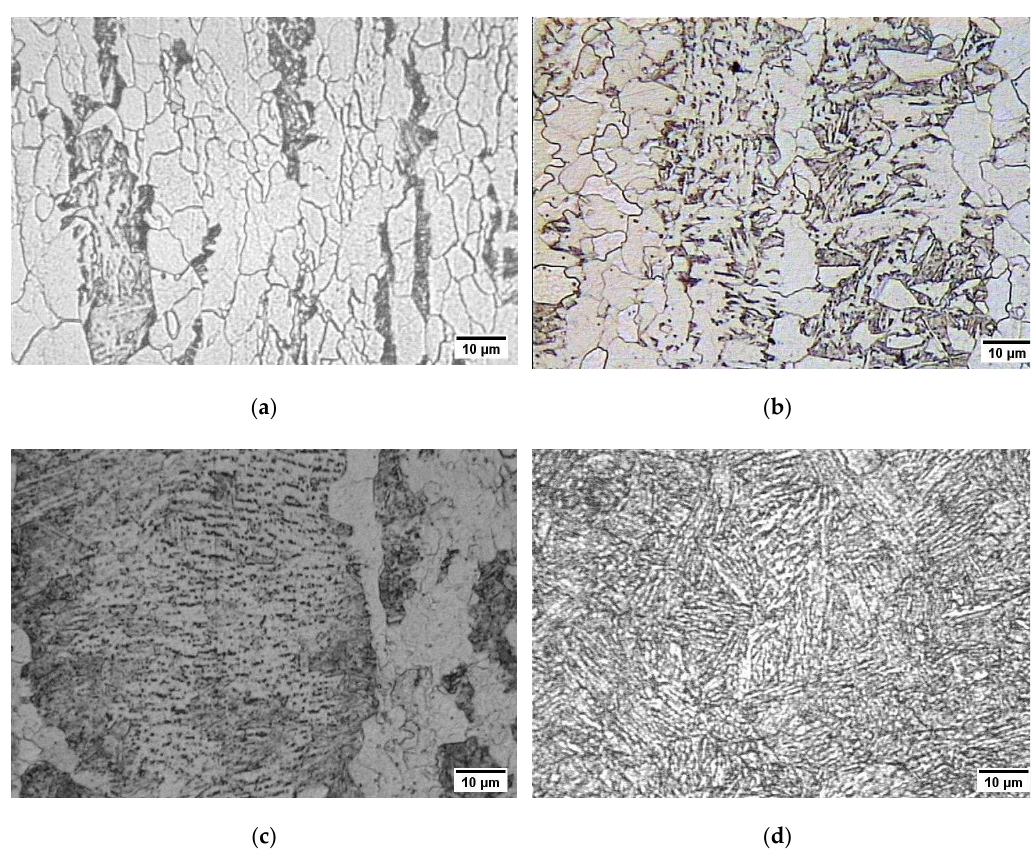
Figure 1. Microstructure of the testes (500 × ): ( a ) X70SS steel (Nital attack); ( b ) X80 steel (Picral attack); ( c ) X100 steel (ferric chloride attack); ( d ) 30NiCrMo12 steel (Nital attack). Table 2. Mechanical properties of the tested